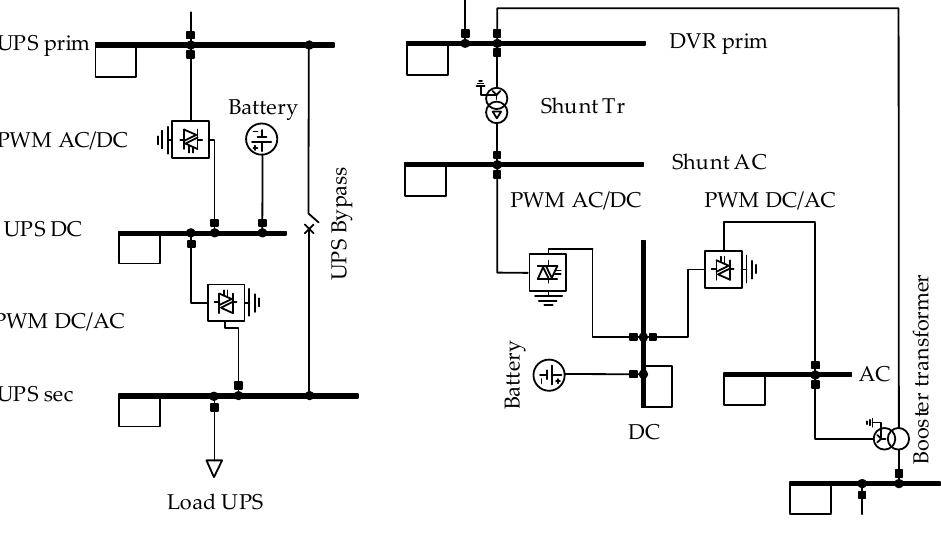
Figure 17. PowerFactory models of UPS and DVR.